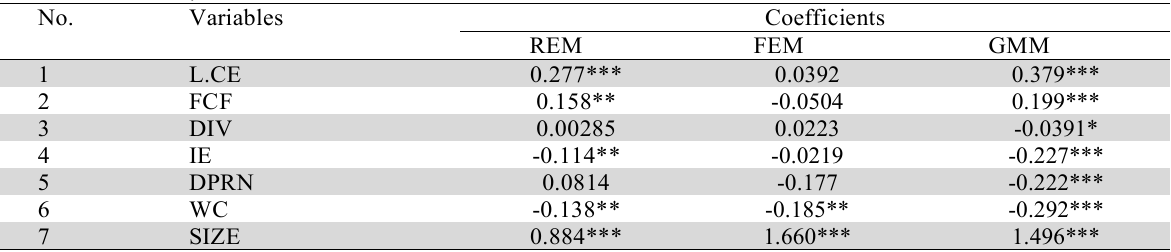
Results from REM, FEM and